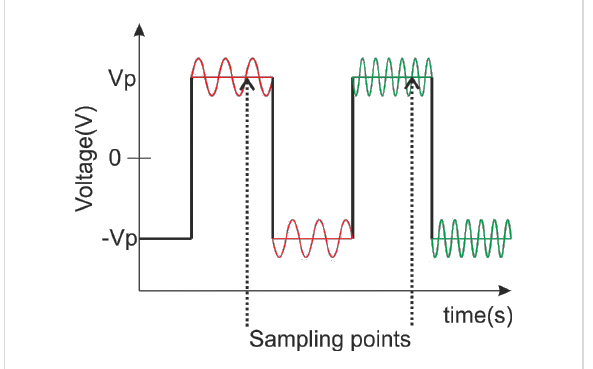
Figure 7: Driving waveform for impedance measurements. V p is peak voltage.